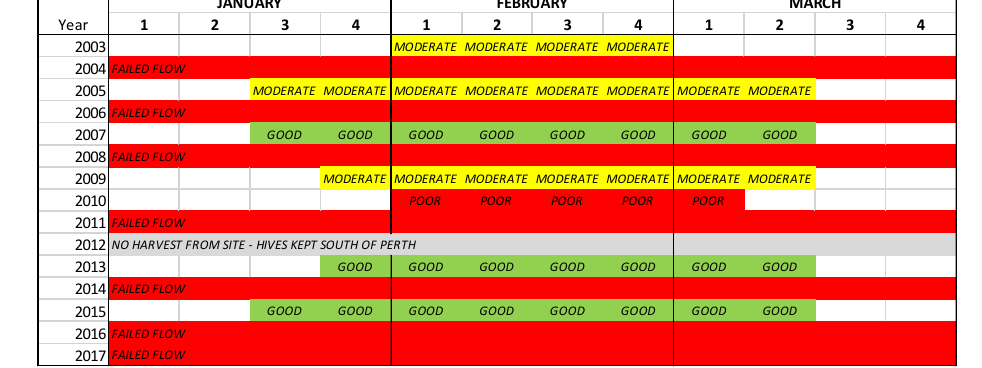
Table 5. Honey harvest data from Mundaring, Western Australia